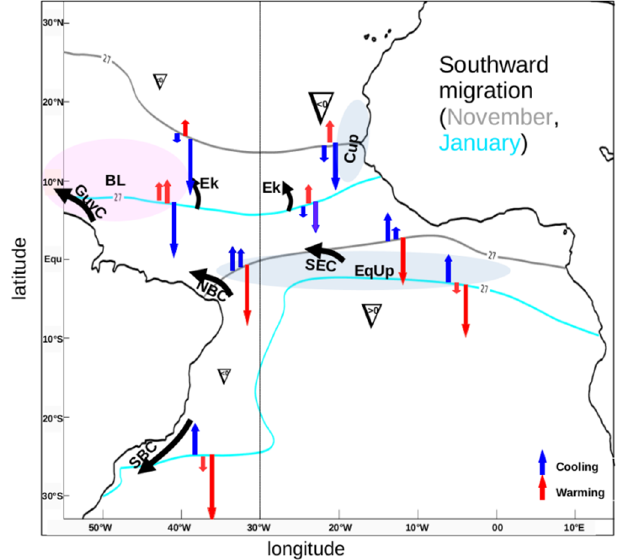
Figure 8. Same as Figure 7, but for the AWP southward migration during boreal autumn (Novem- ber, grey contour) and boreal winter (January, cyan contour). grey contour) and boreal winter (January, cyan